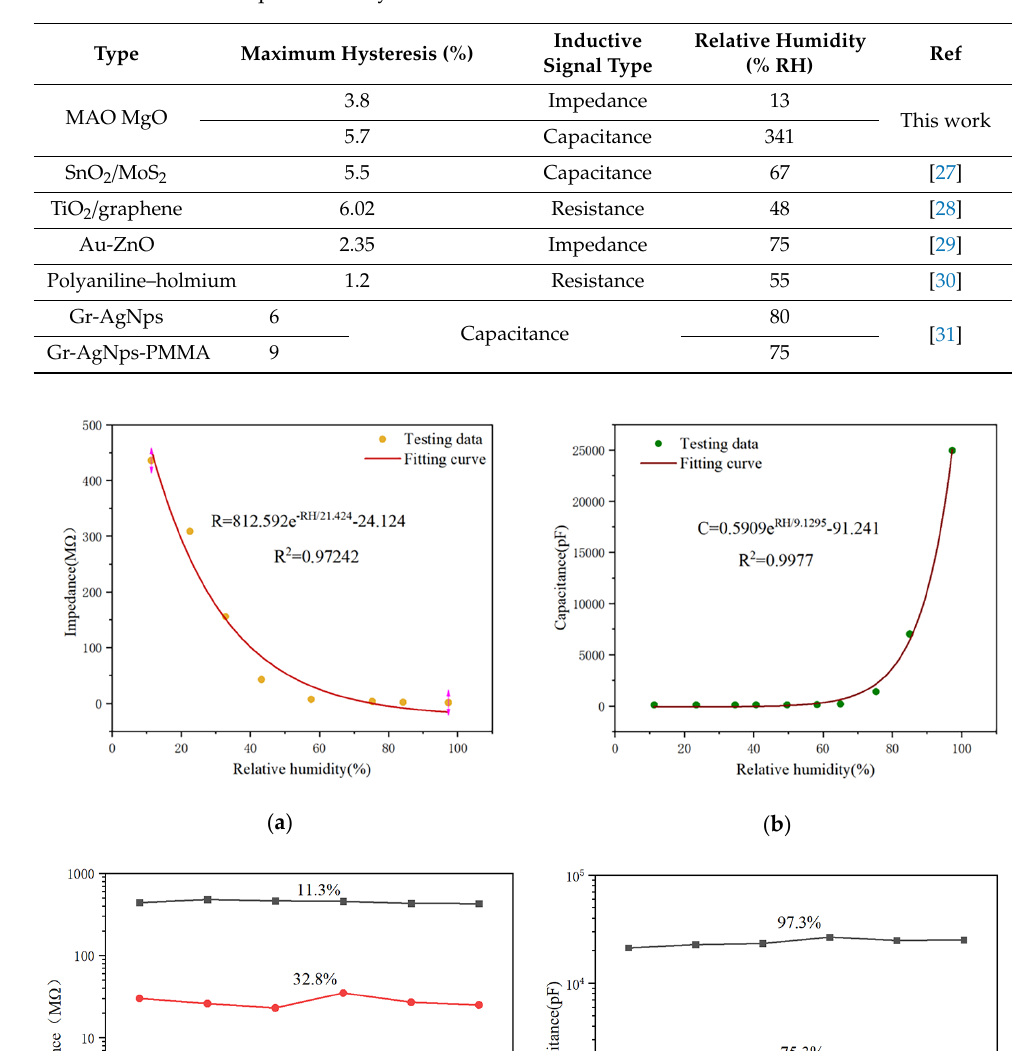
Figure 8a,b represent the exponential fitting of the response curves of the two humidity sensors, respectively. The response signals of the two sensors are used as a function of relative humidity, and their functional expressions are expressed. The coe ffi cient of determination R 2 is 0.9724 and 0.9977, respectively, indicating a good curve fitting. Figure 8c,d show that the two humidity sensors have good stability in the low humidity (11.3%, 32.8%, and 57.6%) and in the high humidity (57.6%, 75.3% and 97.3%) environments, respectively. Table 2. Comparison of hysteresis e ff ects of several moisture-sensitive materials.